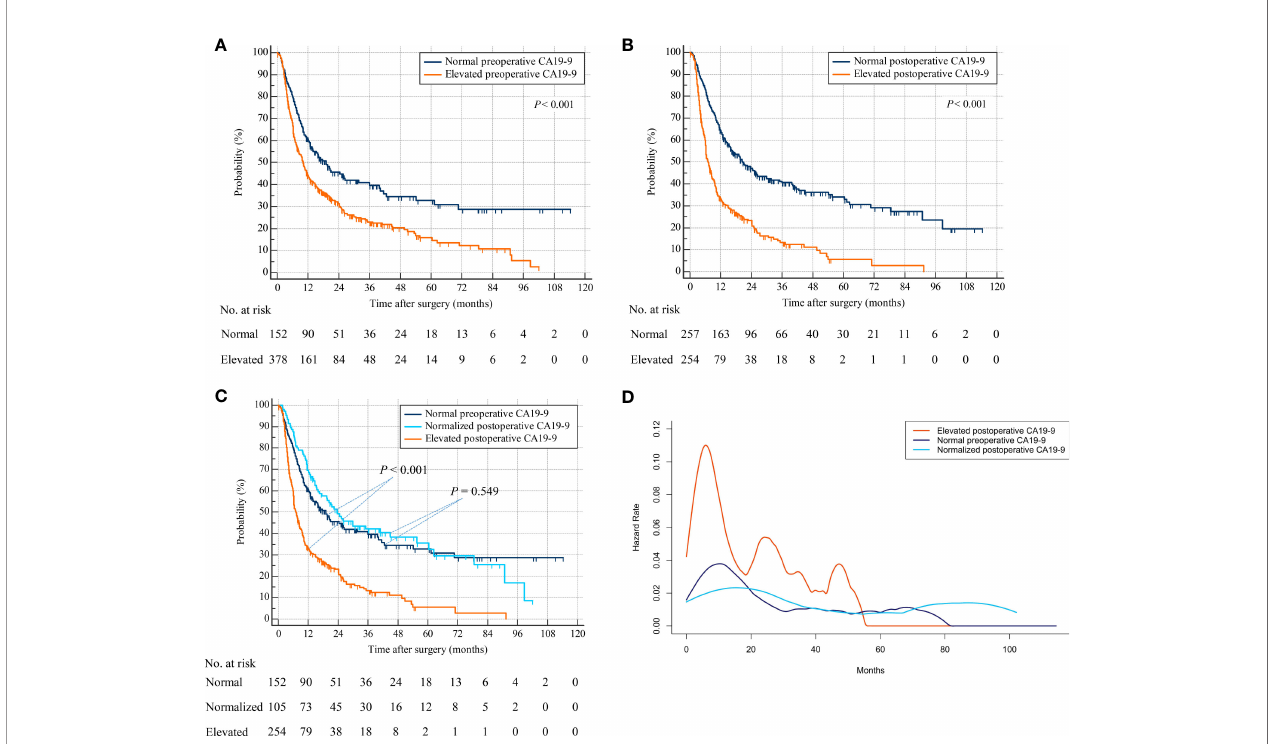
FIGURE 2 | Recurrence-free survival by preoperative and postoperative CA19-9 levels. (A) Patients with normal versus elevated preoperative CA19-9. (B) Patients with normal versus elevated postoperative CA19-9. (C) Patients with normal preoperative versus normalized or persistently elevated postoperative CA19-9. (D) Hazard functions for tumor relapse in the three patient